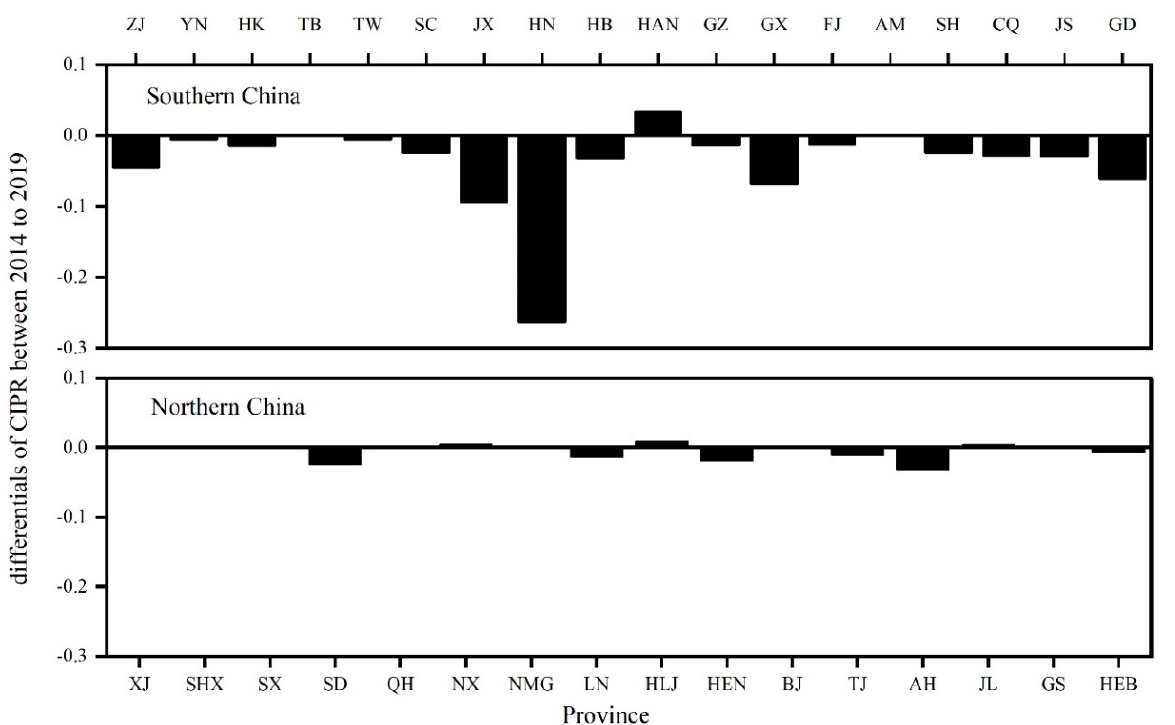
Figure 13. Variation in RCIPR in China from 2014 to 2019 at province level. ZJ is Zhejiang Province; YN is Yunnan province; HK is Hong Kong; TB is Tibet; TW is Taiwan Province; SC is the Sichuan